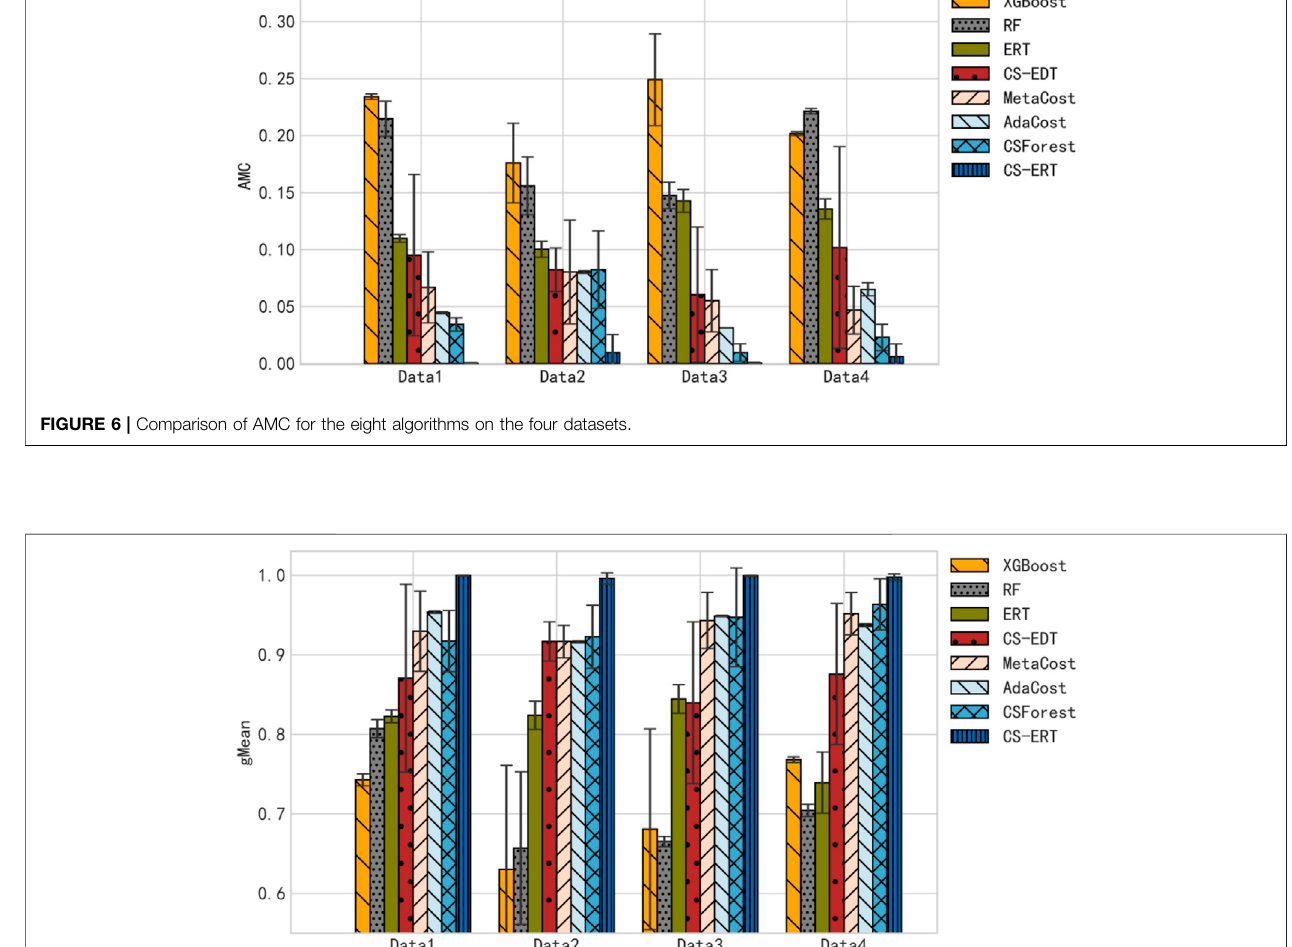
FIGURE 7 | Comparison of gMean for the eight algorithms on the four datasets.